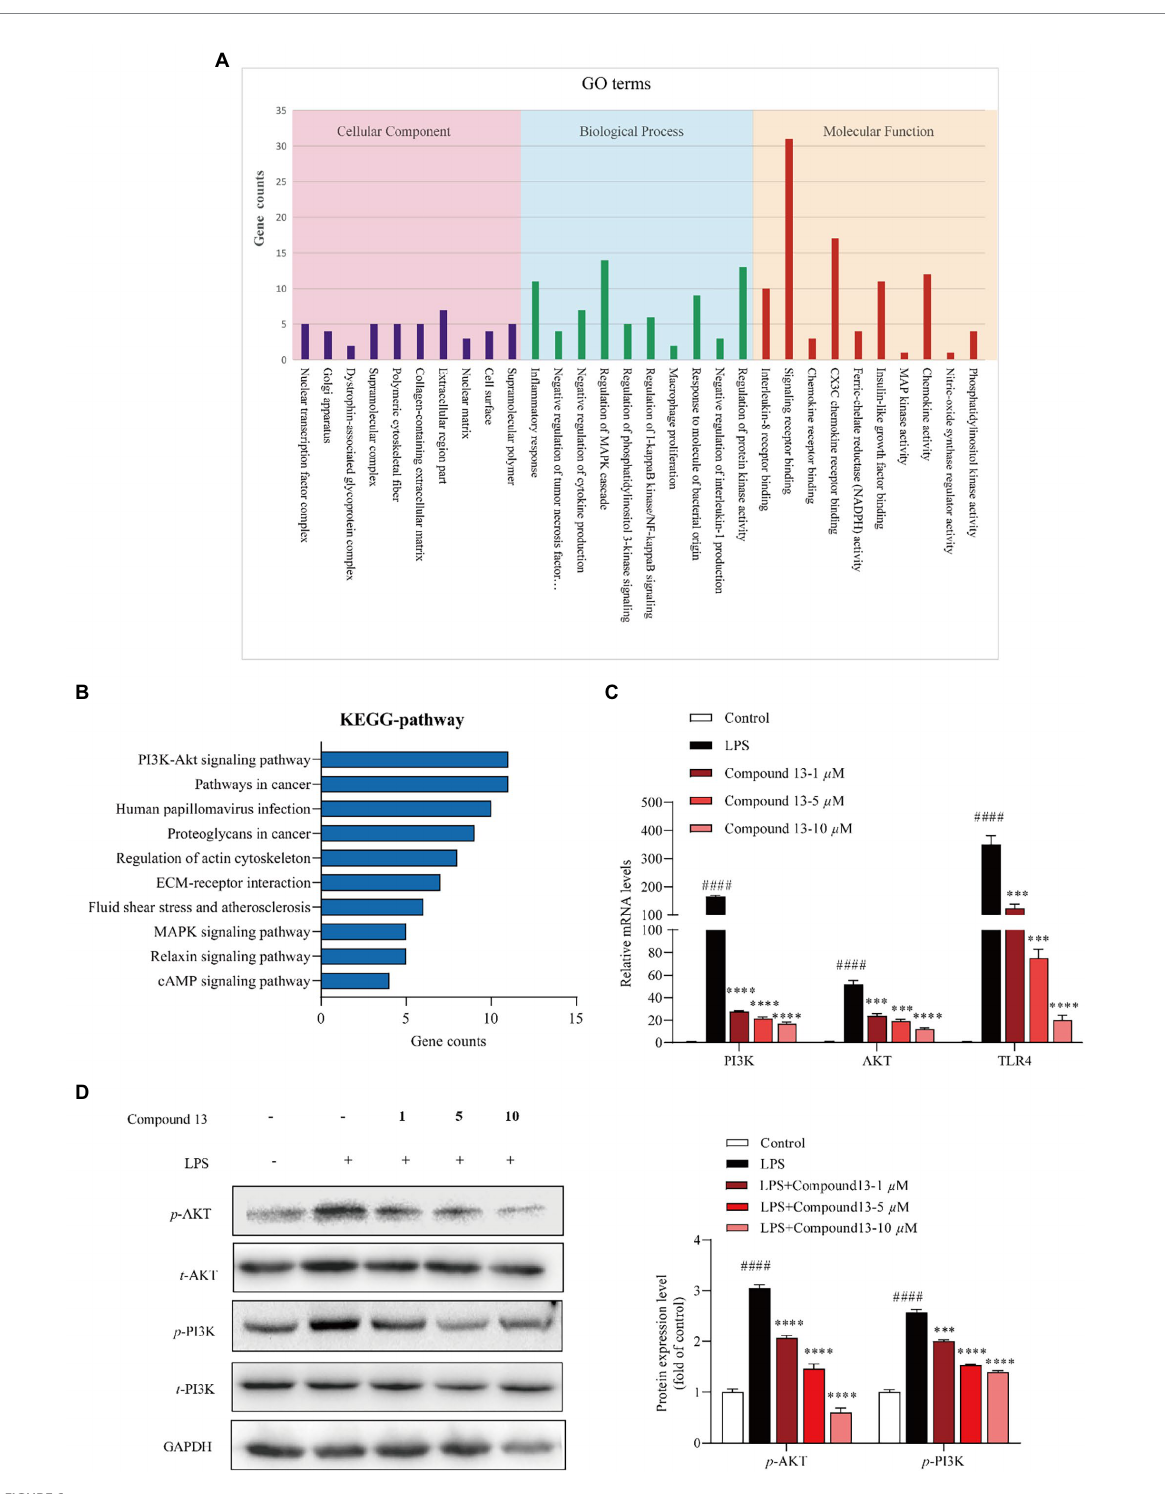
FIGURE 6 PI3K/AKT signaling pathway was involved in the regulation of LPS-induced inflammation by compound 13 in RAW264.7 macrophages. (A) Inflammation-related GO terms enriched from differentially expressed genes (DEGs) between compound 13 -treated and model RAW264.7 macrophages. (B) Inflammation-related KEGG pathways enriched from DEGs. (C) qPCR analysis of PI3K, AKT, and TLR4 genes normalized by β -actin. All data were presented as the mean ± SD of three independent experiments. p > 0.05, ns; *** p < 0.005, **** p < 0.001 vs. LPS group; #### p < 0.001 vs. control group, n = 3. p value was assessed by two-tailed Student’s t -test. (D) Immunoblotting against the PI3K, AKT proteins, n = 3. All data were presented as the mean ± SD of three independent experiments. *** p < 0.005, **** p < 0.001 vs. LPS group; #### p < 0.001 vs. control group, n = 3. p value was assessed by two-tailed Student’s t